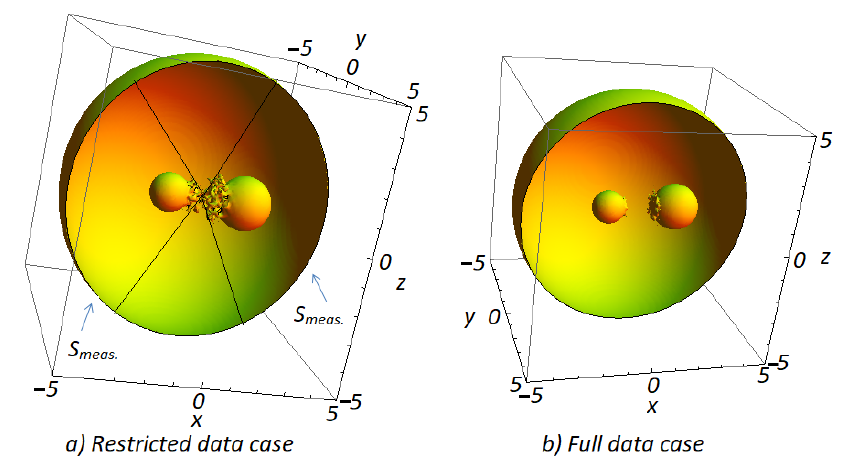
Figure 13. Reconstruction for the disconnected scatterer case: Detecting two spheres with radii equal to 1 and 1 √ centered at the points x = 2 and x = − 1 of the x -axis, 2